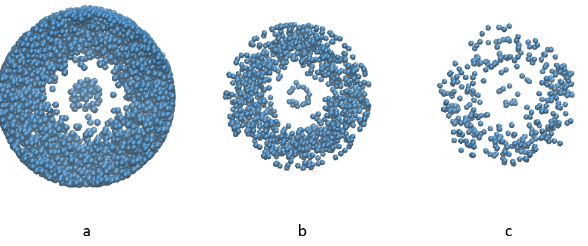
Figure 14. Liquid distribution comparison of different liquid contents ( a ) 28.9% liquid ( b ) 11.9% liquid ( c ) 4.5% liquid.